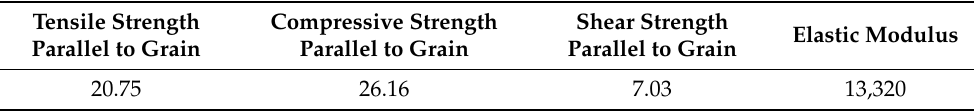
Table 2. Basic mechanical parameters of timber (unit: MPa).